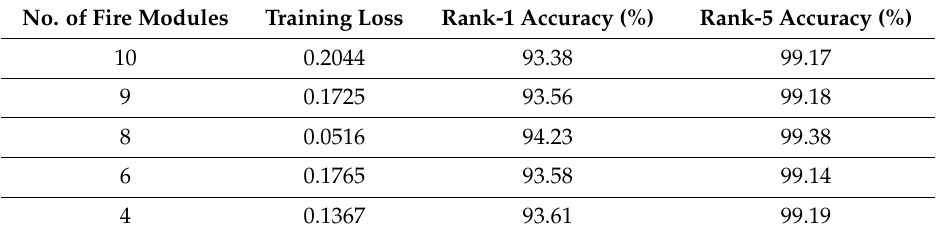
Table 7. SqueezeNet performance of models with respect to Fire